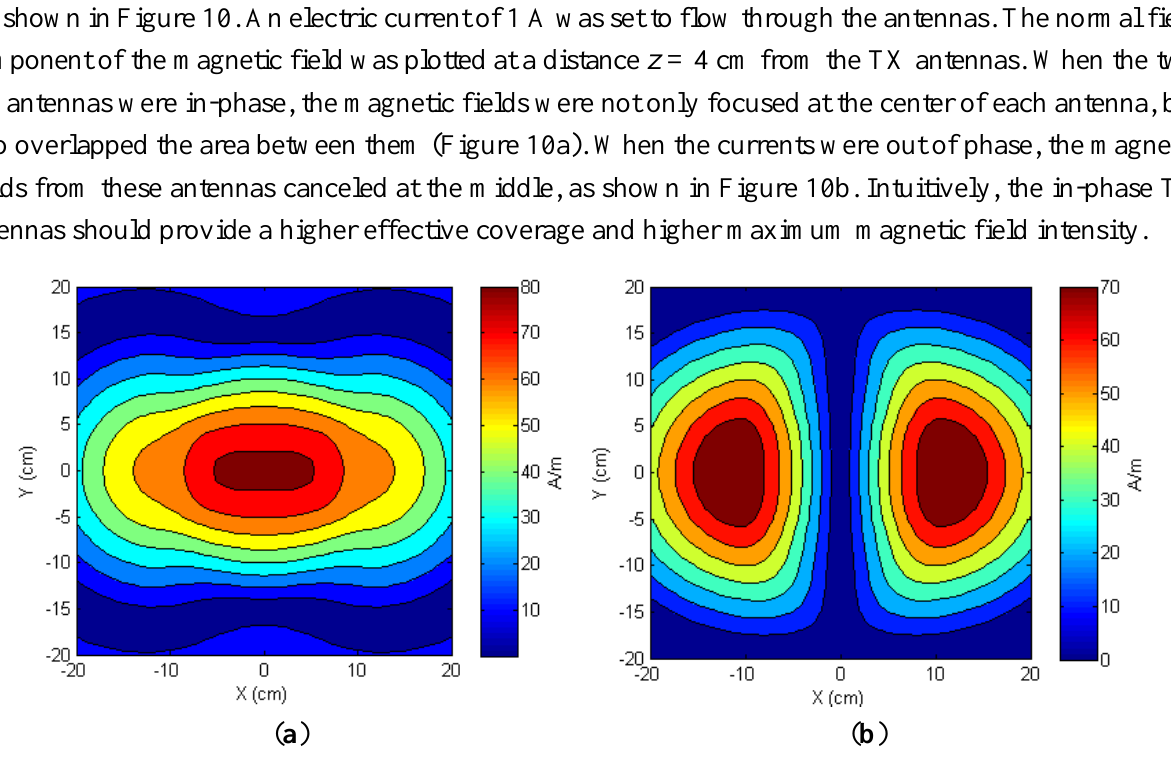
Figure 10. Simulation of the normal component of magnetic fields at a distance z = 4 cm from the two TX antennas when two antennas were ( a ) in-phase and ( b )